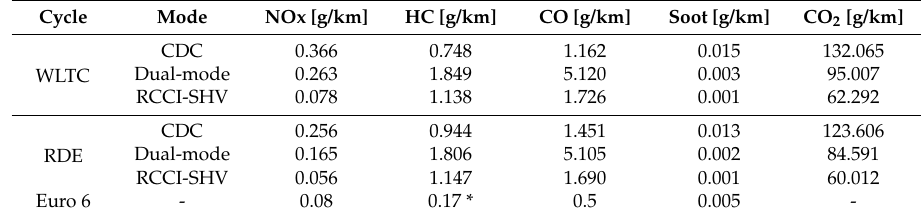
Table 7. Engine-out emissions for the different modes and the two driving cycles with the respective Euro 6 limits in g/km.